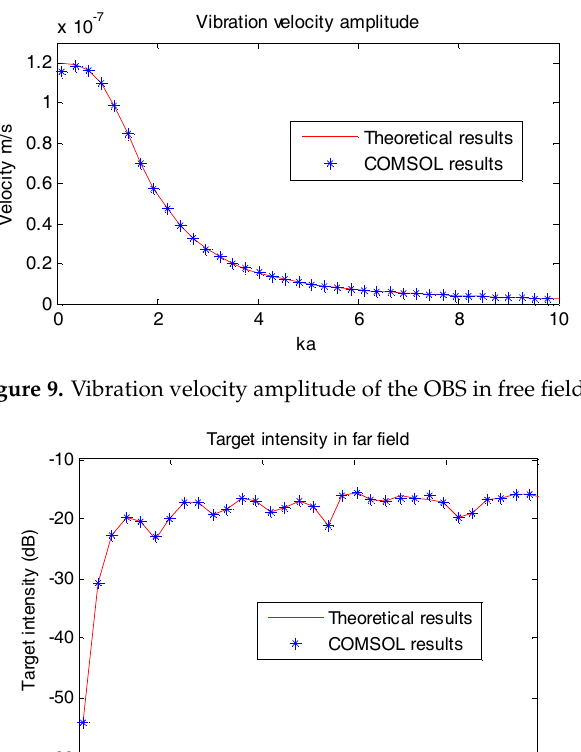
Table 3. Material parameters of sediment.